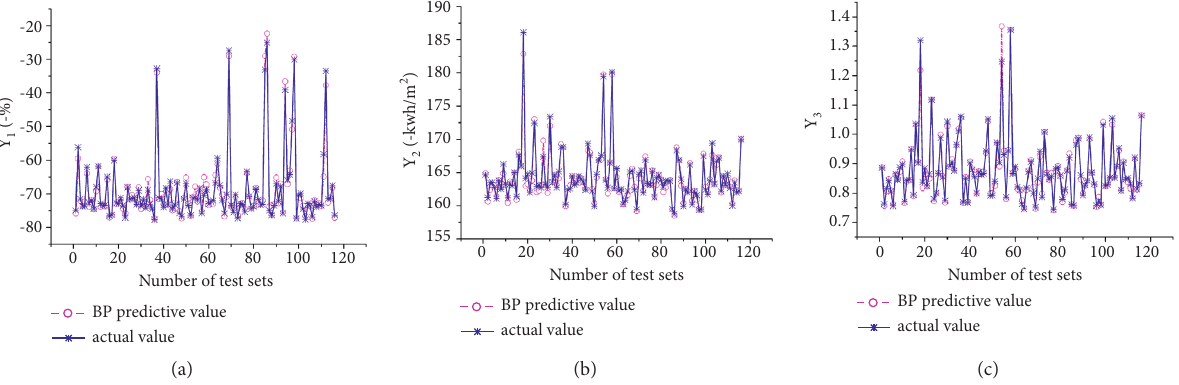
Figure 14: Predicted value and target value of BP neural network. (a) Y represents PMV.